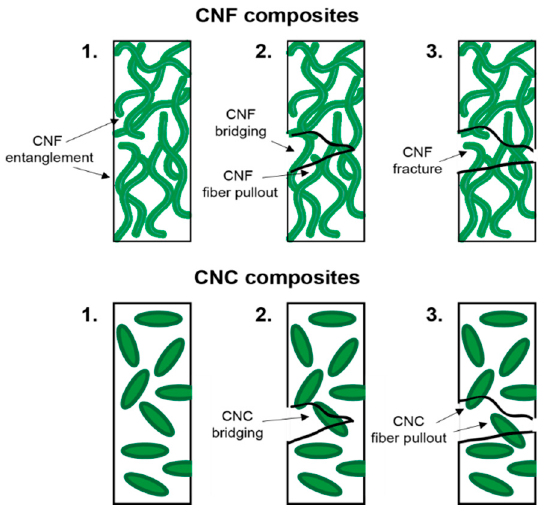
Figure 6. Illustrations of fracture mechanisms of CNC and CNF nanocomposites; ( 1 ) before stress, ( 2 ) during mechanical stress, and ( 3 ) after stress. Longer CNF fibrils can bridge the fracture surface, resulting in a stronger composite.